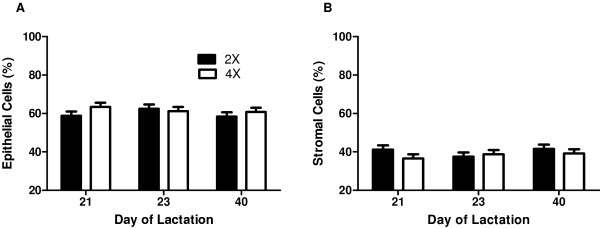
Mammary cell population dynamics. Percentage of A. epithelial or B. stromal cells in mammary tissue of cows (n = 6) assigned to unilateral frequent milking (UFM; twice daily milking (2×) of the left udder half, four times daily milking (4×) of the right udder half) for days 1 to 21 of lactation. Mammary biopsies from both udder halves were obtained on d 21, 23, and 40 of lactation. Each bar represents Least Squares mean ± pooled standard error. The proportion of mammary epithelial and stromal cells was not affected by 4× milking or by day of lactation (P ≥ 0.40).